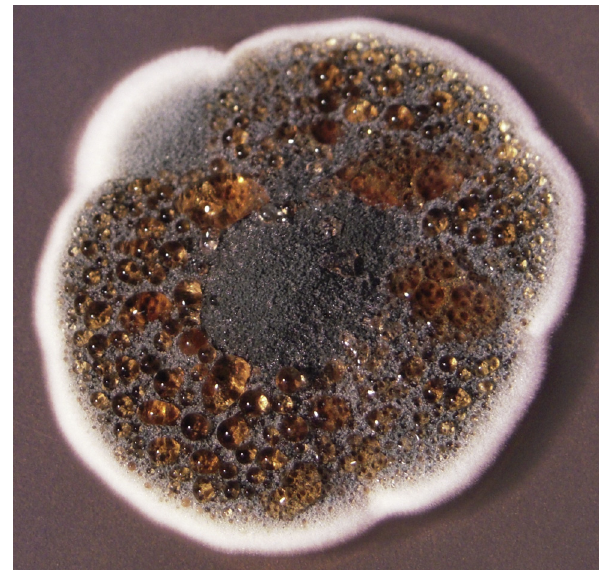
Aspergillus spp. macroscopic image in malt extract agar medium at 37 ◦ C.